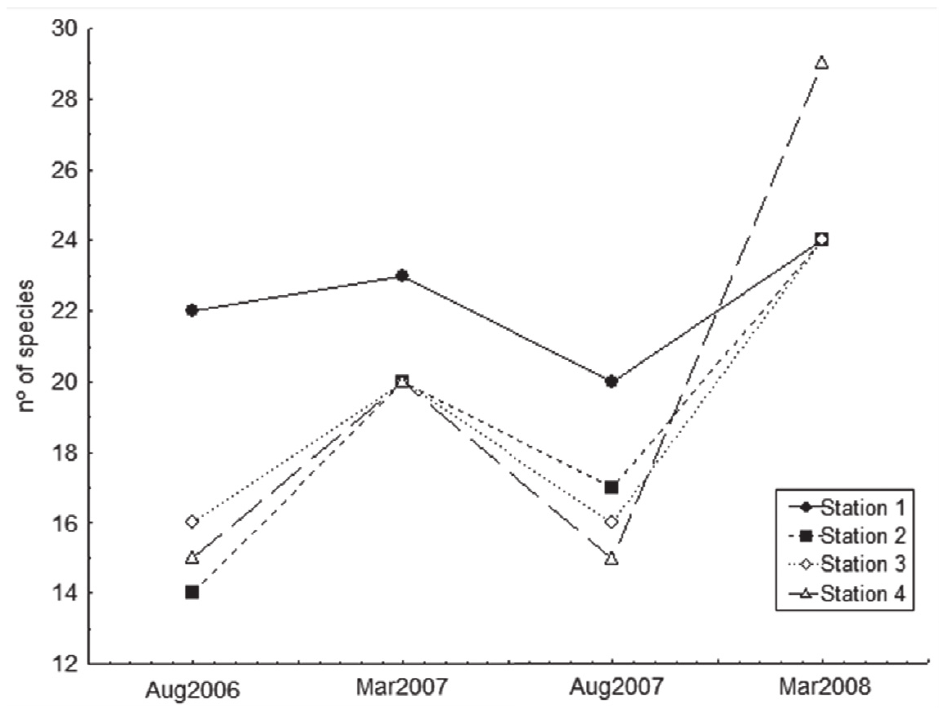
Figure 3 - Species richness (number of species) recorded in the Arrombado Lake during the study period in all sampling stations. aug=August; mar=